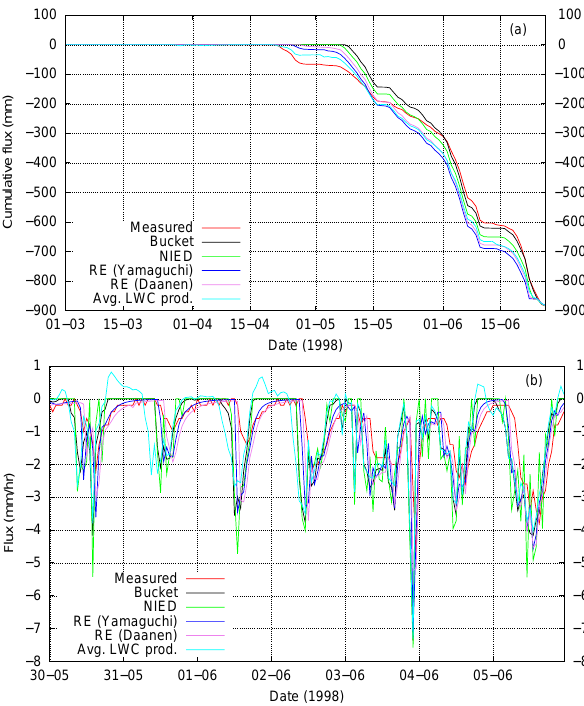
Fig. 1. Measured and modelled snowpack runoff sums (mm) over the snow seasons for WFJ (a) and CDP (b) . Fig. 2. Cumulative snowpack runoff at WFJ for the lysimeter mea-